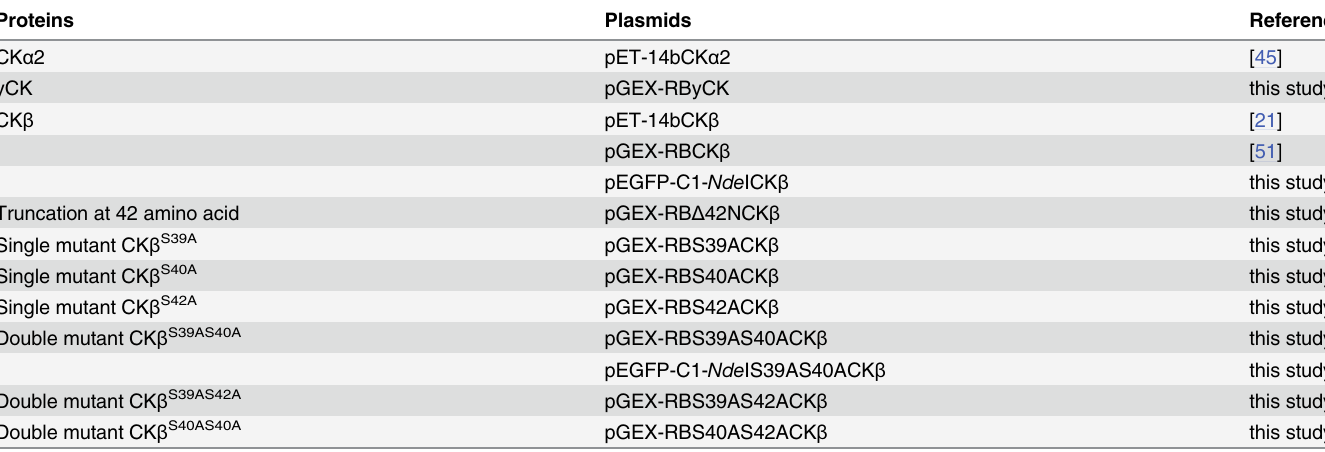
Table 3. Proteins and expression plasmids used in this